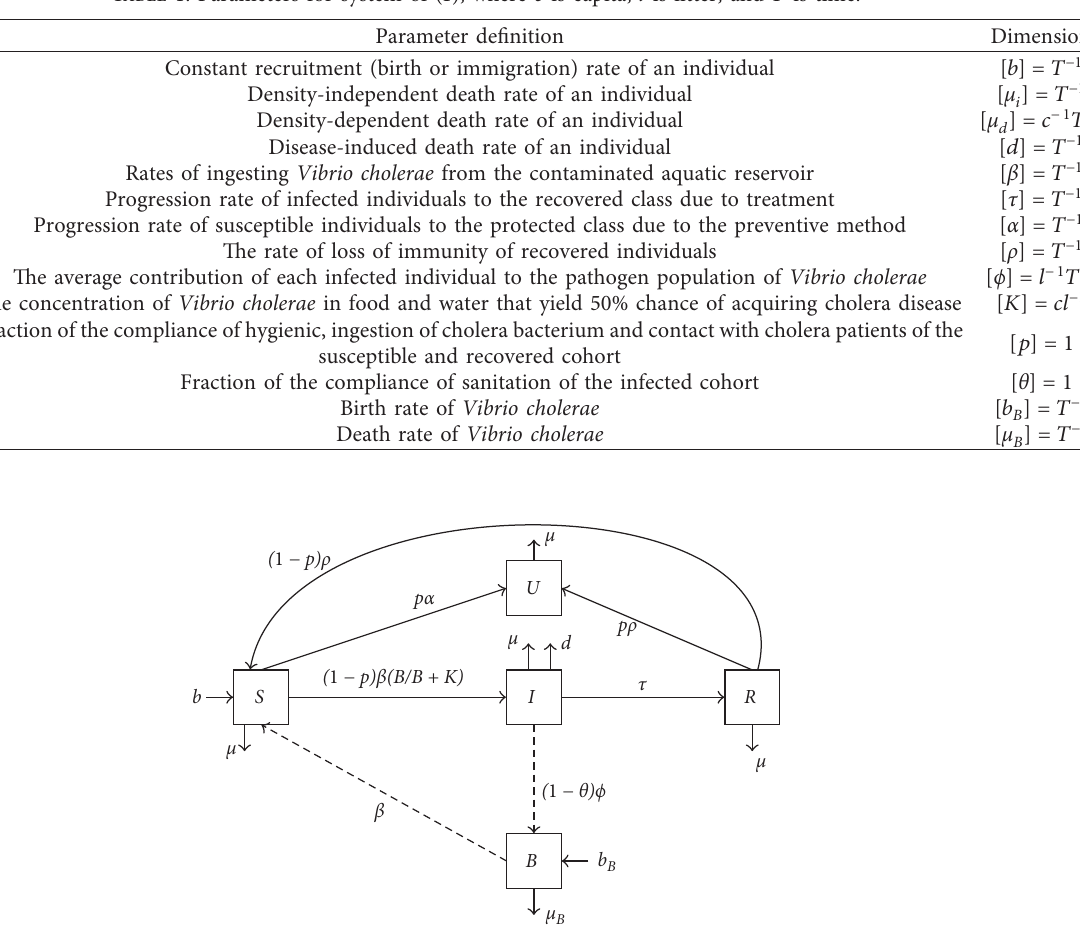
Figure 1: The schematic depiction of the dynamics and prevention measures of